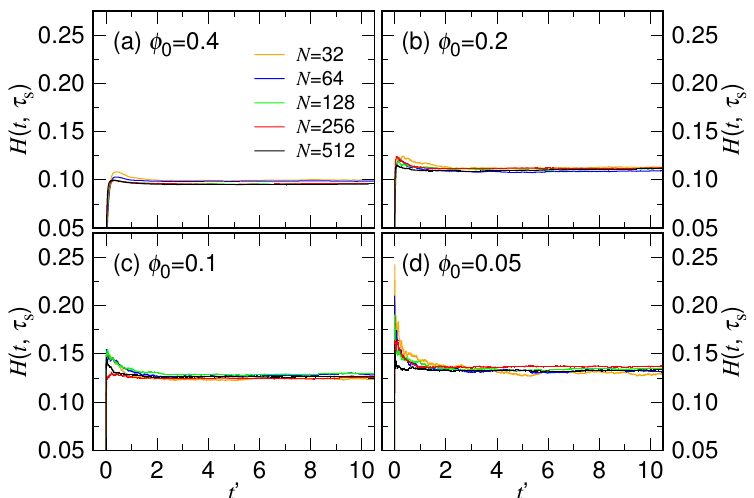
) calculated by using the simulation data R (cid:48) and Figure 15. Quantity H ( t , τ s ) = log ( R (cid:48) ) / log ( 1 + t τ s the fitting parameter τ s , plotted against t (cid:48) for the case ( a ) φ 0 = 0.4, ( b ) φ 0 = 0.2, ( c ) φ 0 = 0.1, and ( d ) φ 0 = 0.05. The chain length can be read in the legend of Panel ( a